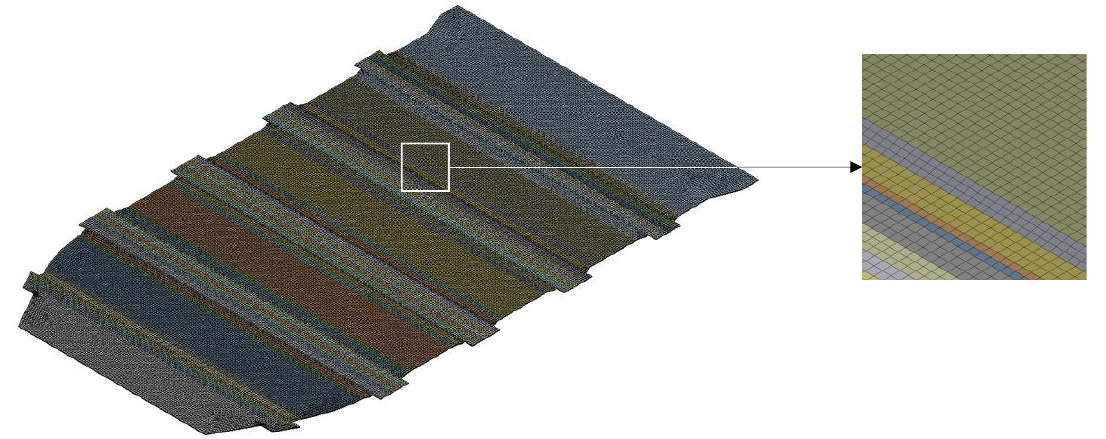
Figure 15. Mesh of aluminum battery housing model.